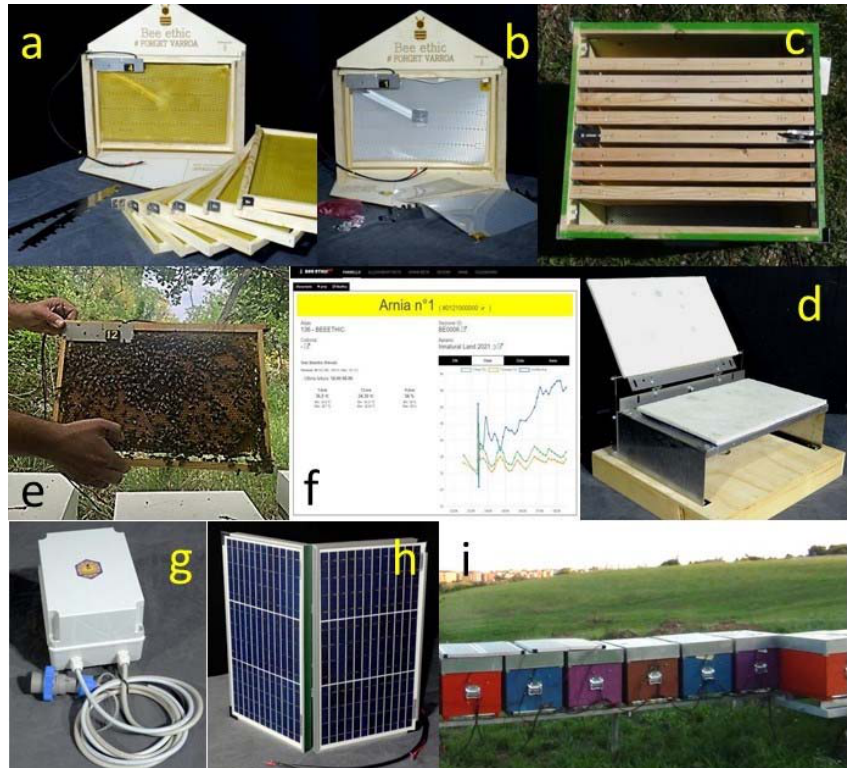
Figure 1. The Bee Ethic system: ( a ) hive kit: two stainless steel spacers and eight thermal frames; ( b ) the microchip inserted in the probe frame; ( c ) the thermal frames in the hive with the one with the microchip in central position; ( d ) mold for waxing thermal foundations; ( e ) the microchip and sensors integrated in the probe frame; ( f ) the main parameters of a hive as shown by BEE ‐ SMART control unit; ( g ) 24 ‐ volt AC/DC transformer to connect the Bee Ethic system to a socket; ( h ) photovoltaic panel; ( i ) apiary not served by the electric network.